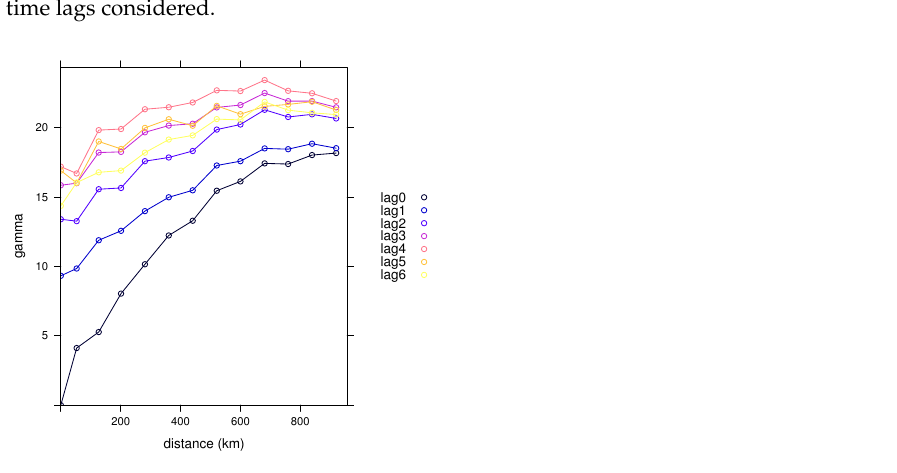
Figure 7. Huber’s semivariograms (with tuning constant equal to 1.345) of the daily Tmax from the NOAA data with respect to the seven time lags